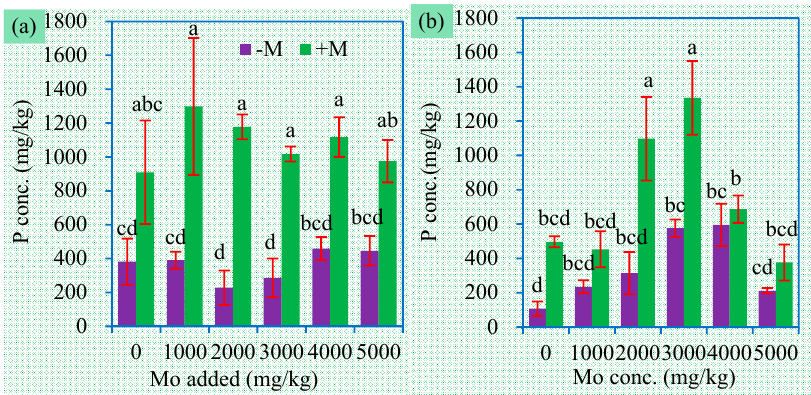
Figure 5. Shoot ( a ) and root ( b ) P concentrations (mean ± SE, n = 4) of sweet sorghum exposed to different concentrations of Mo. -M and +M represent non-AM inoculation and inoculation with Claroideoglomus etunicatum BEG168, respectively. Different letters over the bar represent significant differences between the means among different treatments using one-way ANOVA followed by Duncan’s multiple range test ( p < 0.05). Two-way ANOVA results for shoot P concentrations: AM inoculation: F = 25.9**, Mo: F = 0.3 ns, AM × Mo: F = 0.3 ns; two-way ANOVA results for root P concentrations: AM inoculation: F = 4.2*, Mo: F = 0.7 ns, AM × Mo: F = 1.0 ns. Significance levels: * p < 0.05; ** p < 0.01; ns non-significant effect.